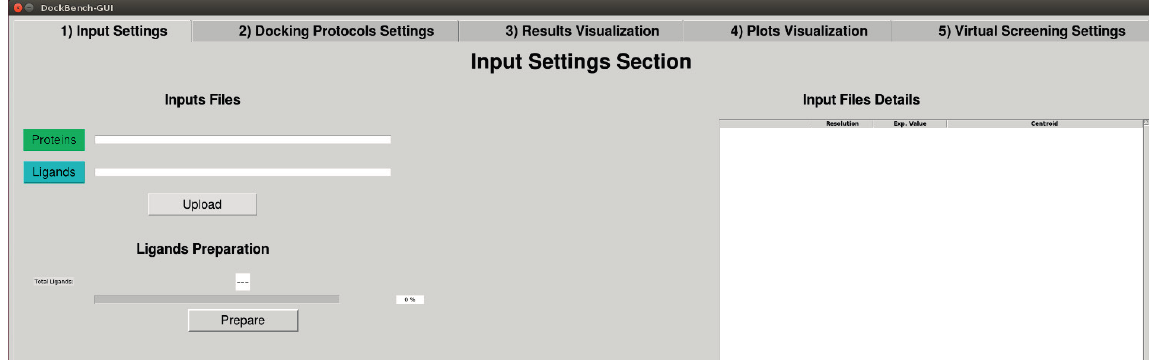
Figure 2. DockBench GUI tabs: (1) Input Settings; (2) Docking Protocols Settings; (3) Results Visualization; (4) Plots Visualization; (5) Virtual Screening